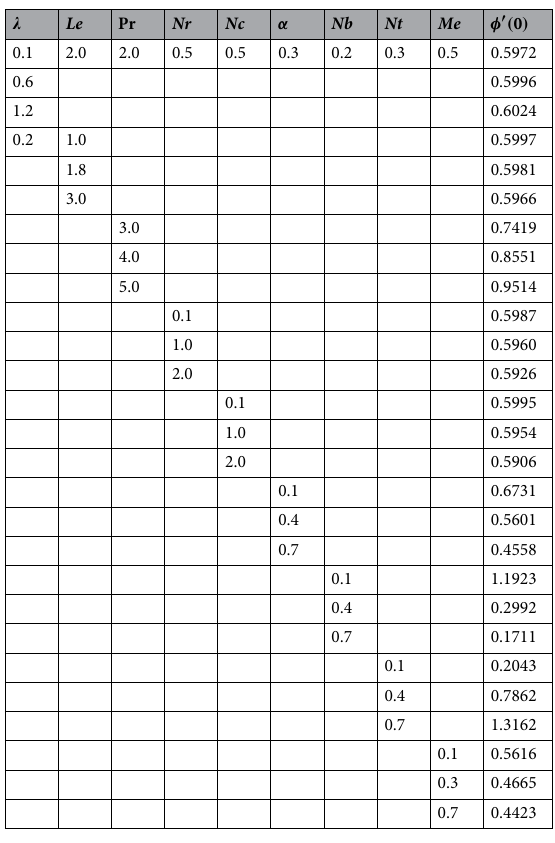
Table 3. Solutions of physical parameters via φ ′ ( 0 ) .